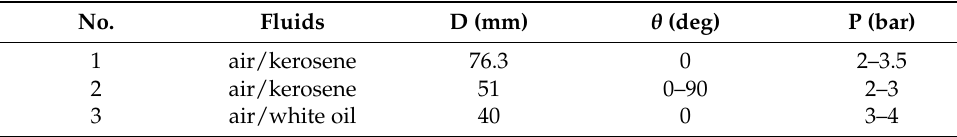
Table 1. Summary of experimental conditions.